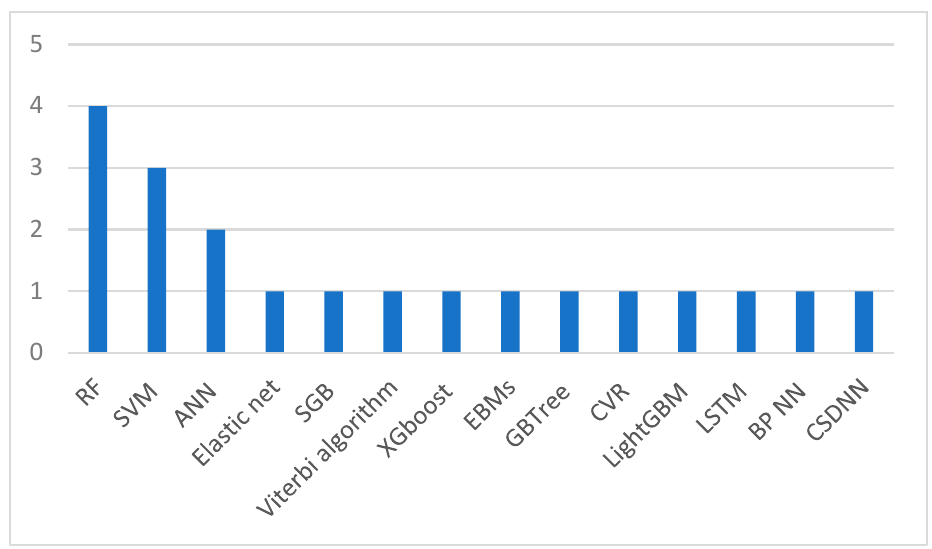
Figure 2. ML and DL algorithms that achieved the best results in each study. Table 4. Summary of the previous studies that used clinical data. Clinical and